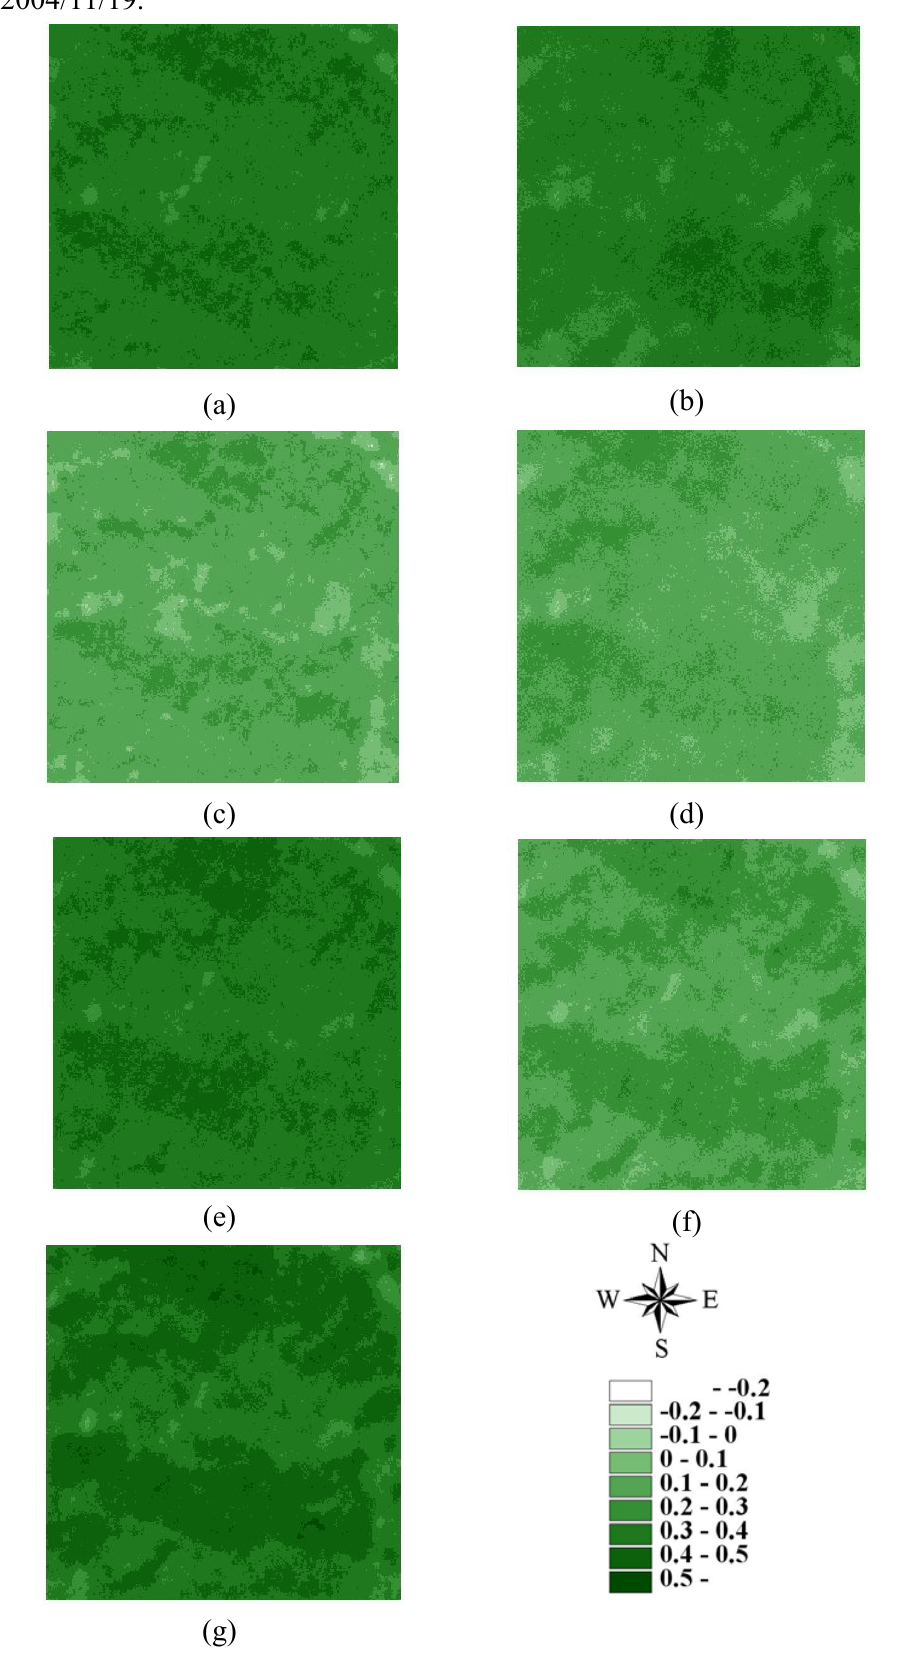
Figure 9. Conditional simulated NDVI images based on 3,000 samples in area A on (a) 1996/11/08, (b) 1999/03/06, (c) 1999/10/31 (d) 2000/11/27, (e) 2001/11/20, (f) 2003/12/17, and (g)